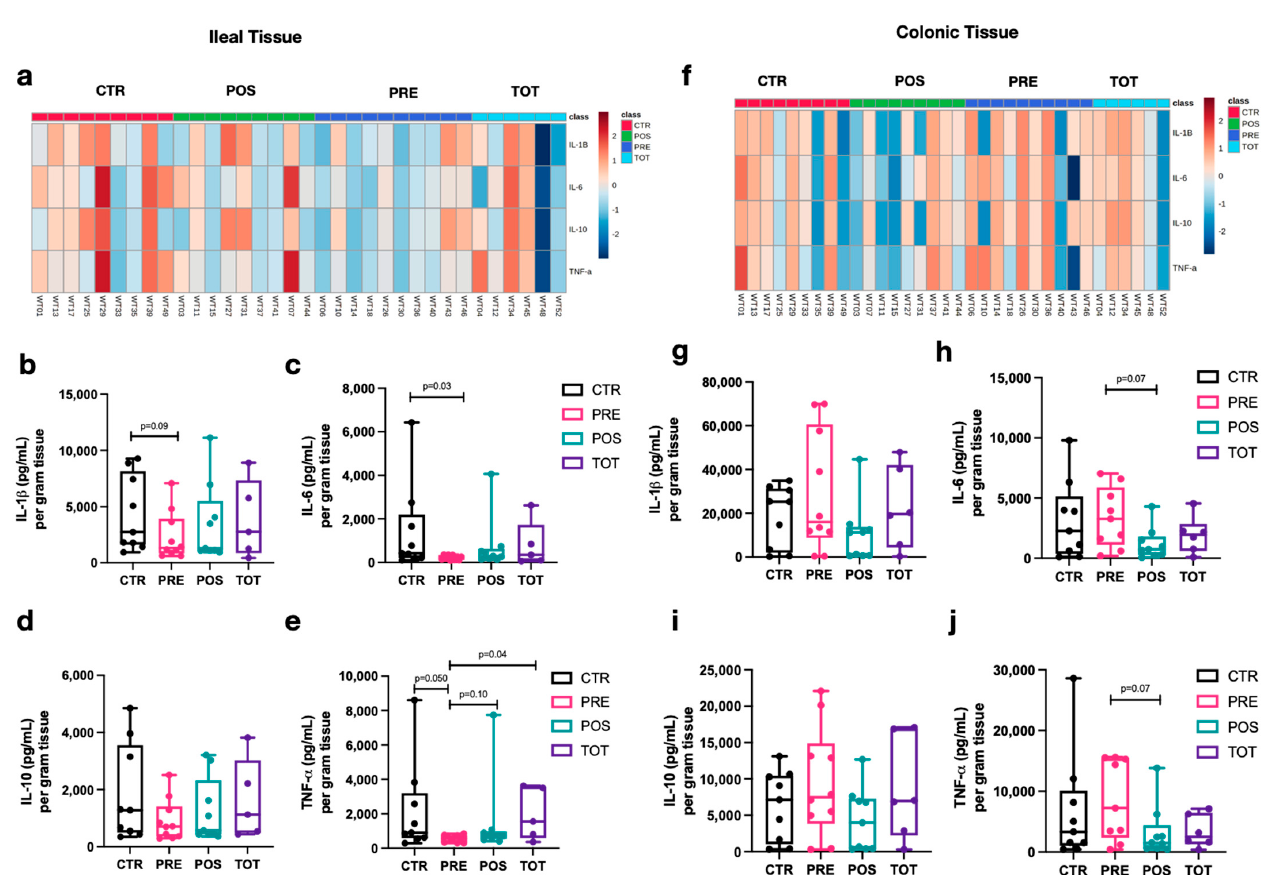
Figure 5. Tissue ‐ weight ‐ adjusted cytokine concentrations in perianastomotic ileal and colonic tissue homogenate. Box ‐ and ‐ whisker plots represent the distribution of each group at W4. The median is represented by the middle line while the upper and lower borders of the box plot identify the 75th and 25th percentile, respectively. The whiskers correspond to the maximal and minimal values. ( a ) Heatmap of ileal tissue cytokine concentrations after logarithmic transformation of data. ( b – e ) Concentration of IL ‐ 1 β , IL ‐ 6, IL ‐ 10, and TNF ‐ α , respectively, per gram of dry ileal tissue. ( f ) Heatmap of colonic tissue cytokine concentrations after logarithmic transformation of data. ( g – j ) Concentration of IL ‐ 1 β , IL ‐ 6, IL ‐ 10, and TNF ‐ α , respectively, per gram of dry colonic tissue.